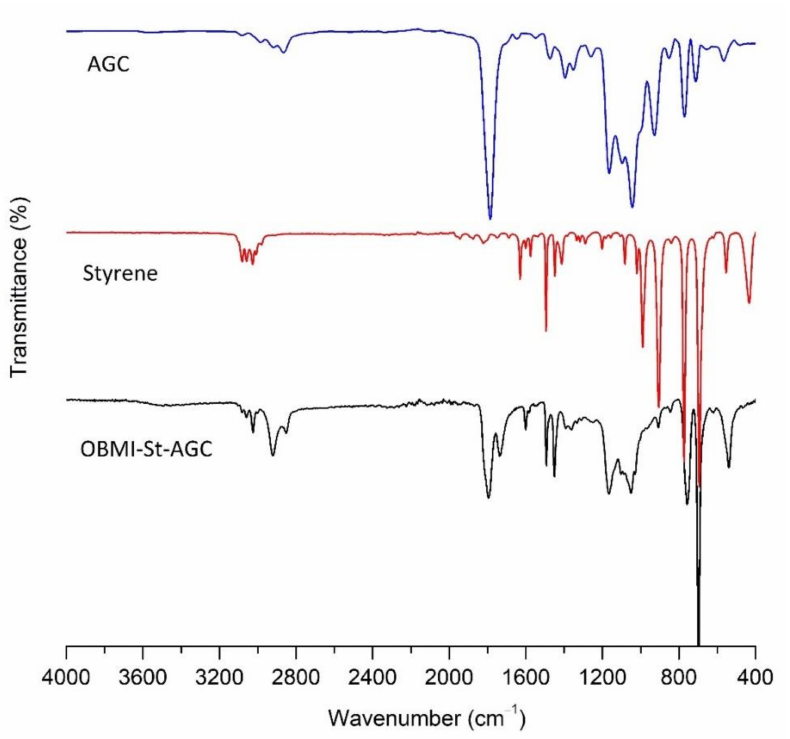
Figure 4. The FTIR spectra of AGC, styrene, and OBMI-St-AGC. Additionally, in the comparison of spectrum a, b, and c in Figure 5, the change in the peaks’ intensity at the 1000–1200 cm − 1 region is due to the incorporation of Si-O-C and CH 2 - Si by means of APTES, and the increase in Si-O peak intensity at 963 cm − 1 is due to APTES incorporation [15,53]. These results showed that the APTES was successfully combined with the OBMI-St-AGC chain through the reaction of its NH 2 with cyclic carbonate groups.